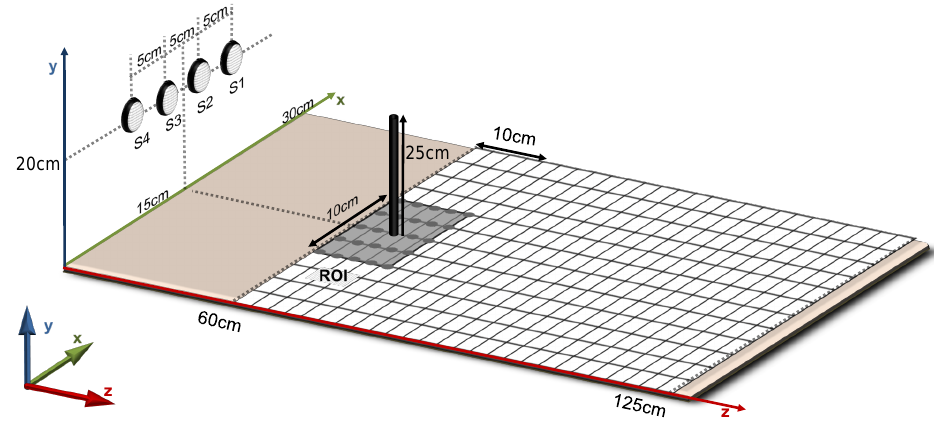
Figure 3. Controlled experimental environment